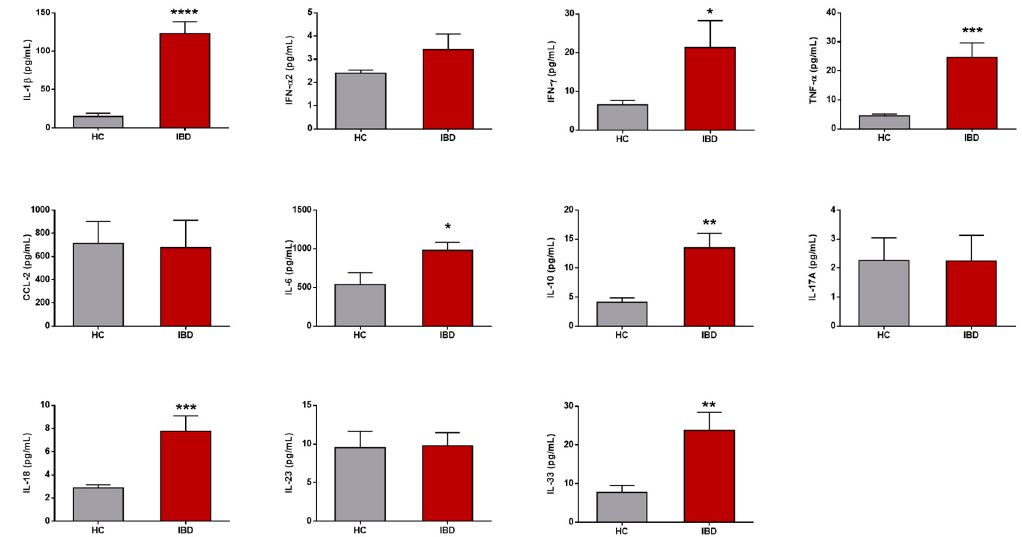
Figure 1. Mucosal cytokines in health and inflammatory bowel disease. Mucosal cytokine levels (pg / mL) in cell-free biopsy culture supernatants from healthy controls (HCs) and patients with inflammatory bowel disease (IBD) following overnight culture in resting conditions. Results are expressed as mean ± SEM. Unpaired t -tests were applied for each cytokine. p -values < 0.05 were considered significant (* < 0.05, ** < 0.01, *** < 0.001, **** < 0.0001). CCL-2, chemokine (C–C) motif